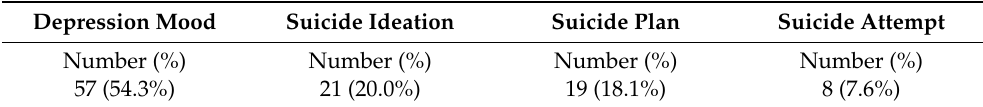
Table 2. The distribution of suicide stages among the experimental group.